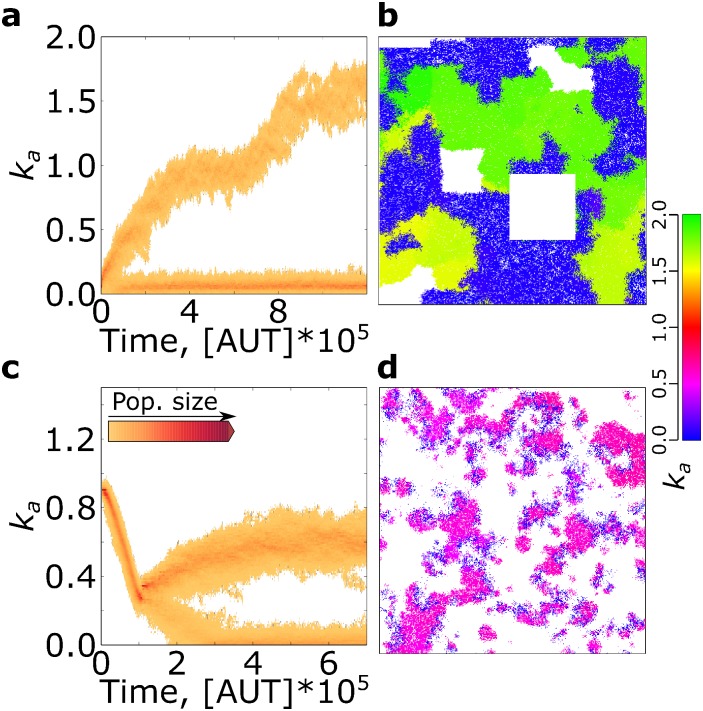
Smaller disruptions and increased cost of replication lead to speciation.a: Time plot of the distribution of ka in a simulation with smaller disruptions. Disruptions are as follows: every 50 time steps, 16 square (1002) patches of the lattice are turned to empty at random positions. Lattice size 10242, other parameters as in Fig 1. b: A snapshot of the simulation with disruptions (an area of 4002 is displayed). c: Time plot of the distribution of ka in a simulation where duration of replication is Δtrepl = 4 AUT. All other parameters are the same as above, except for kdiss = 0.1. d: A snapshot of the simulation with longer replication time (lattice size 10242, displayed: 4002).